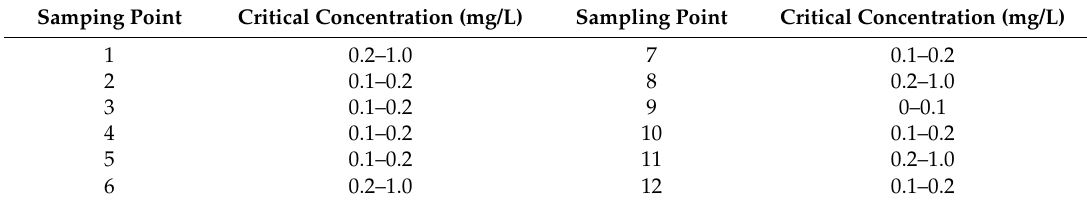
Figure 5. The release amount and proportion of P in sediments. Table 5. Critical concentration ranges of phosphorus adsorption and release in sediments.